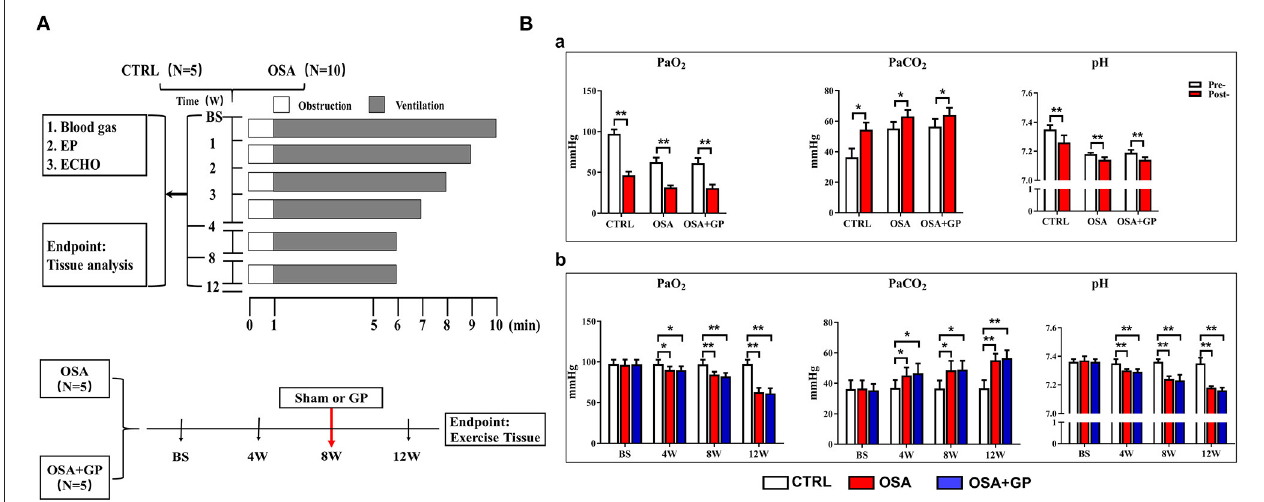
FIGURE 1 | (A) Study protocol performed on the dogs. (B) Changes in blood gas among the three groups. (a) After 1min of apnea in the 12th week of simulating OSA; (b) During the 12-week period of OSA simulation before apnea. * P < 0.05, ** P < 0.01, n = 5. OSA, obstructive sleep apnea; GP, ganglionated plexus; CTRL, control; BS, baseline; EP, electrophysiology; ECHO, echocardiography; Pre-, pre-apnea; Post-, post-apnea; W,